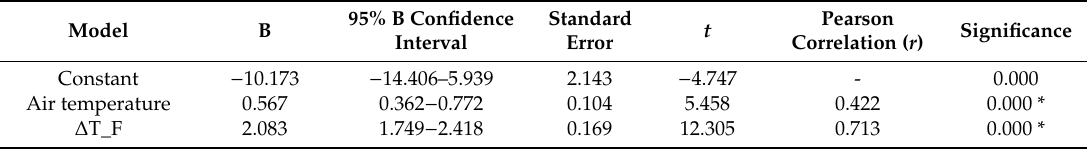
Table 12. Regression analysis using as independent variables: air temperature ( ◦ C) and forearm skin temperature variation ( ◦